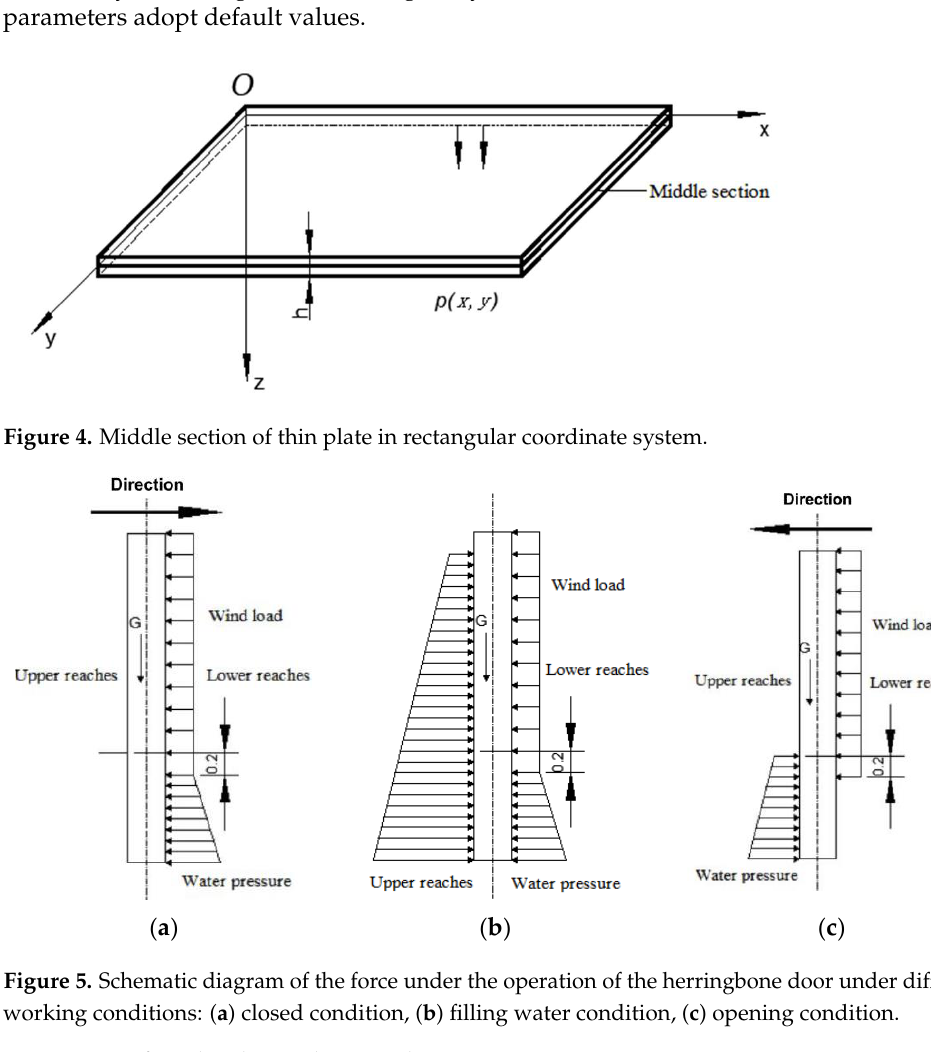
Figure 4. Middle section of thin plate in rectangular coordinate system.